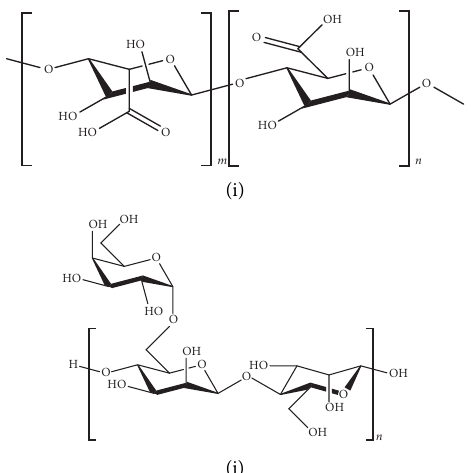
Figure 7: Chemical structure of (a) cellulose, (b) gelatin, (c) polylactic acid, (d) polyhydroxybutyrate, (e) polycaprolactone, (f) polybutylene succinate, (g) chitosan, (h) polyvinyl alcohol, (i) alginate, and (j) gum arabic as biodegradable composite-based food